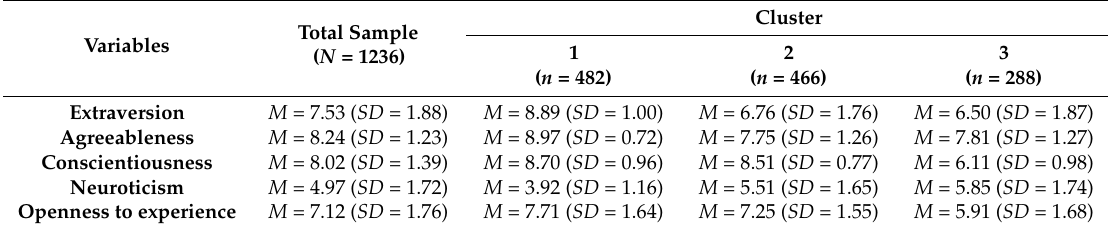
Table 2. Mean scores for the total sample and clusters ( N =